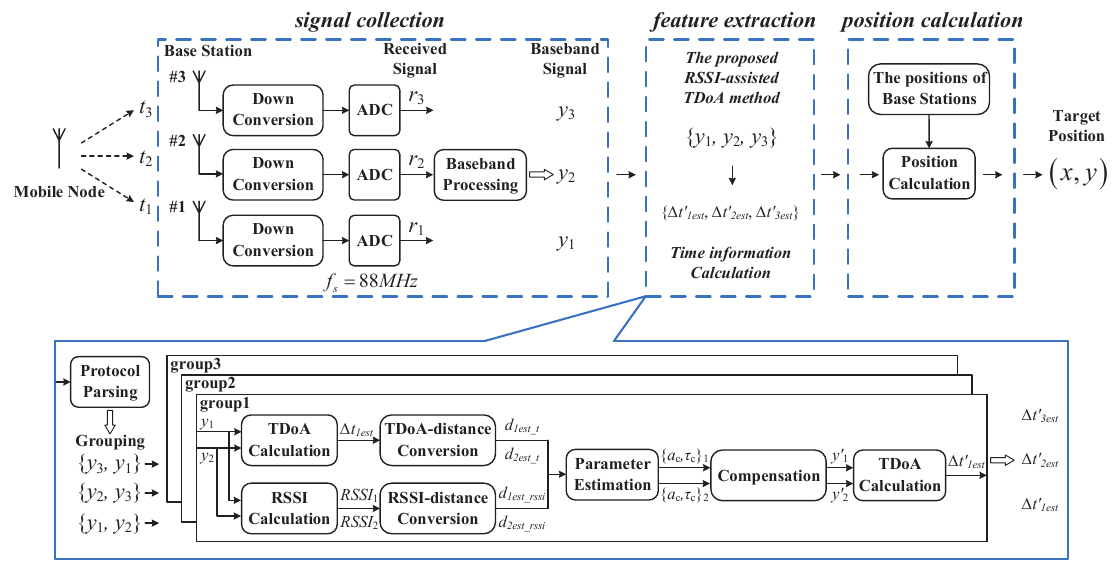
Figure 10. Signal processing flow for 2D position